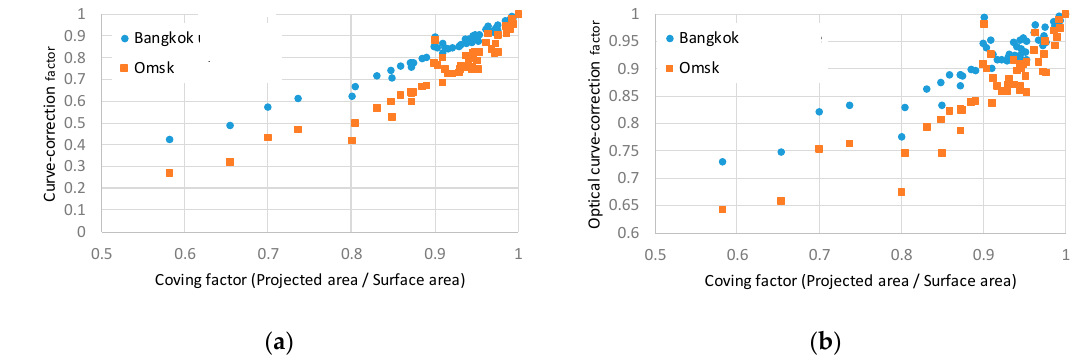
Figure 10. Correction factor vs. representative curve shape parameter (coving factor as f 1 ) in two extreme cases. One is the urban zone in Bangkok (N 13.7° and 4.87 kWh/m 2 /day global horizontal irradiance, GHI), drawn by a blue line, and the other is a rural zone of Omsk (N 54.9° and 3.34 kWh/m 2 /day GHI) drawn in an orange line: ( a ) curve-correction factor f ; ( b ) optical curve correction factor f 2 .